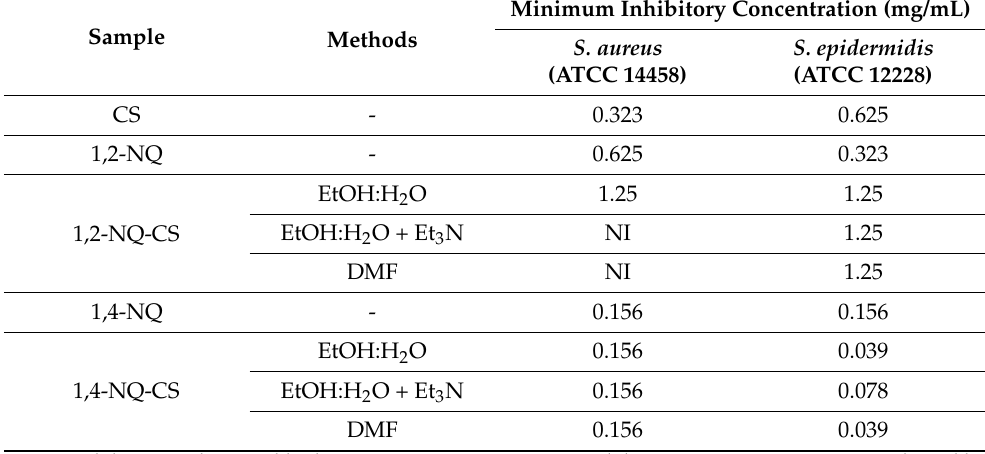
Table 3. Minimum inhibitory concentration (MIC) of free-naphthoquinones, chitosan and chitosan grafted with different naphthoquinones against Staphylococcus of clinical